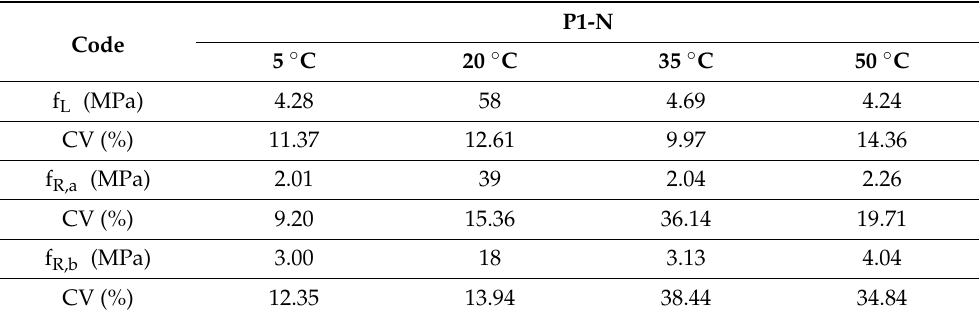
Table 6. Results of the residual flexural strengths obtained at moderate temperatures for uncracked specimens (60 days).